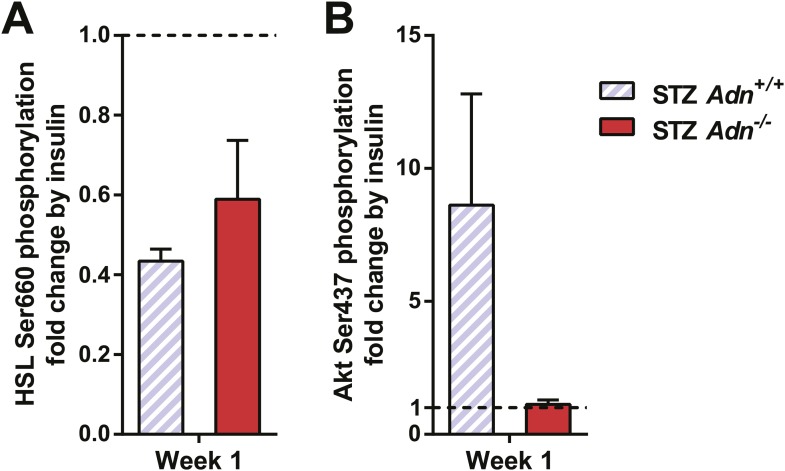
Quantitation of insulin effect on phosphorylation of HSL and Akt.Western blots were quantitated for infrared signal volume subtracting local background. Phosphorylated HSL (A) and Akt (B) were first normalized against the corresponding total protein. The insulin effect on phosphorylation was then calculated by normalizing the insulin-stimulated samples against their corresponding ones before insulin treatment. Data are presented as the mean ± SEM. Related to Figure 4A.